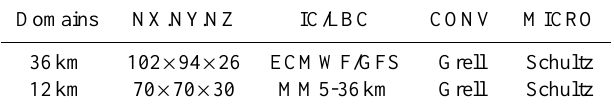
Table 1. Rainfall amount and intensity for the seven study events from radar data and raingauge data.